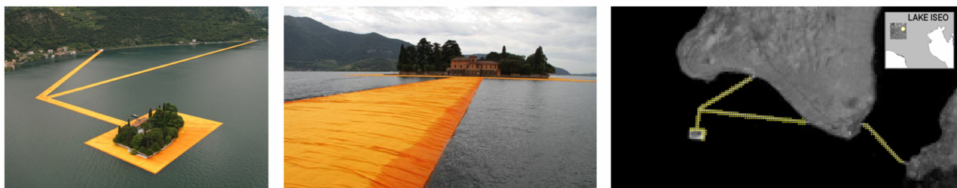
Figure A1. The Floating Piers in Lake Iseo (by Christo, June–July 2016) observed by Sentinel-2. The piers were detected in 274 pixels in three Sentinel-2